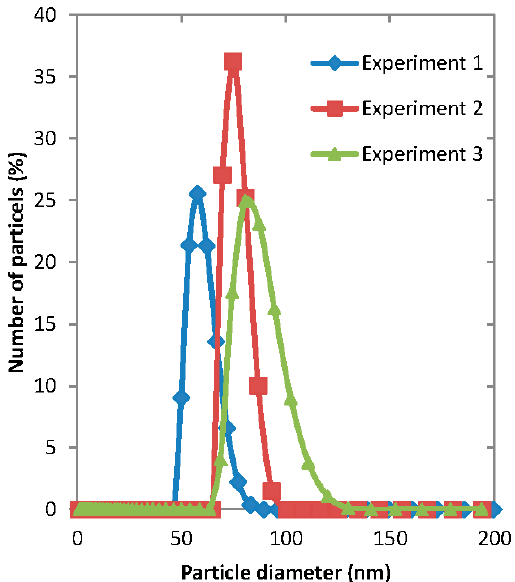
Figure 7. The particle size distribution of polymeric micelles prepared using Dispersion Cell without membrane for three repeated experiments performed under the same conditions. The organic phase was 1 mg·mL − 1 of PEG- b -PCL (A) disolved in acetone, the total volume of the organic phase injected was 5 mL and the volume of the aqueous phase in the cell was 25